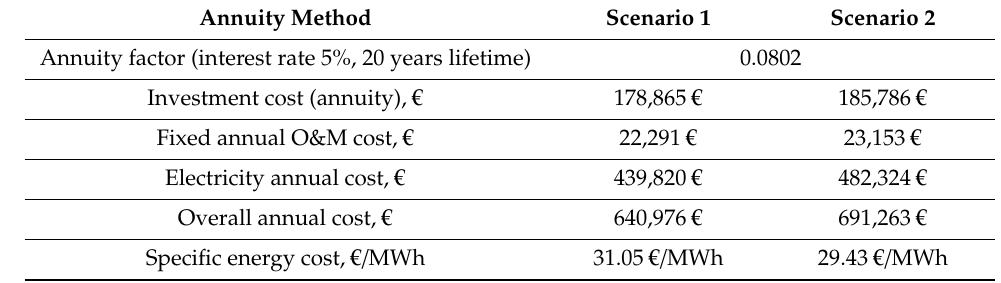
Table 6. Energy production